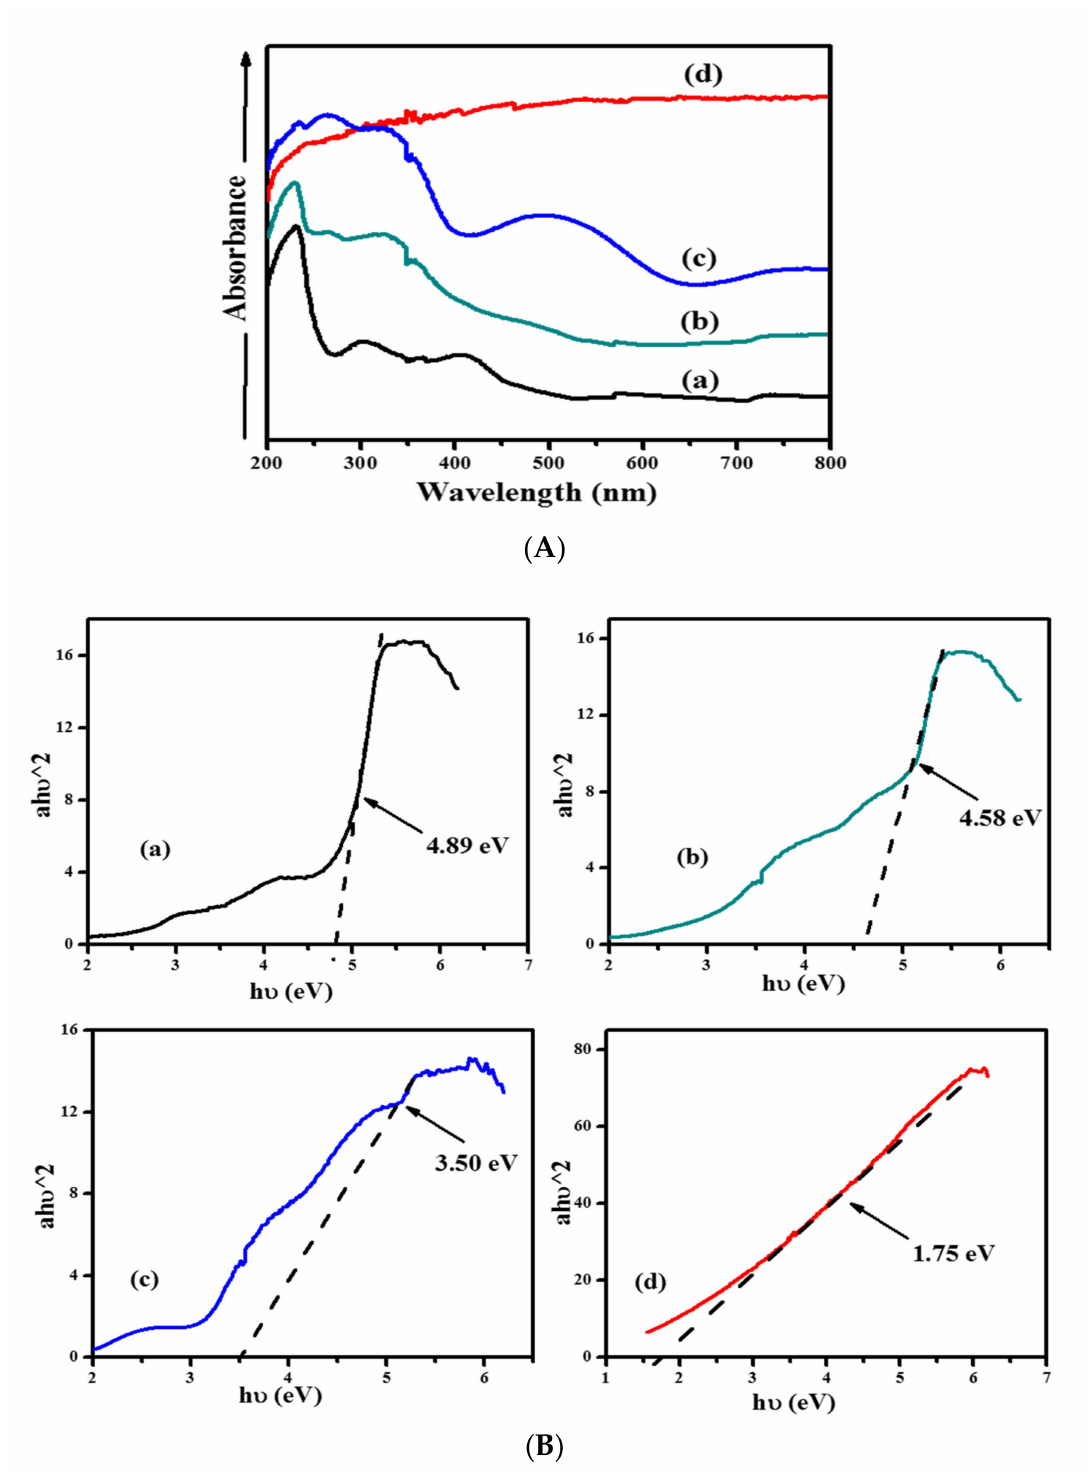
Figure 3. ( A ) UV–vis absorbance spectra of ( a ) ZIF-8 ( b ) 2Cu/ZIF-8N4 ( c ) 2Cu/ZIF-8N3 ( d ) 2Cu/ZIF-8N2 ( B ) Optical band edges of ( a ) ZIF-8 ( b ) 2Cu/ZIF-8N4 ( c ) 2Cu/ZIF-8N3 ( d )